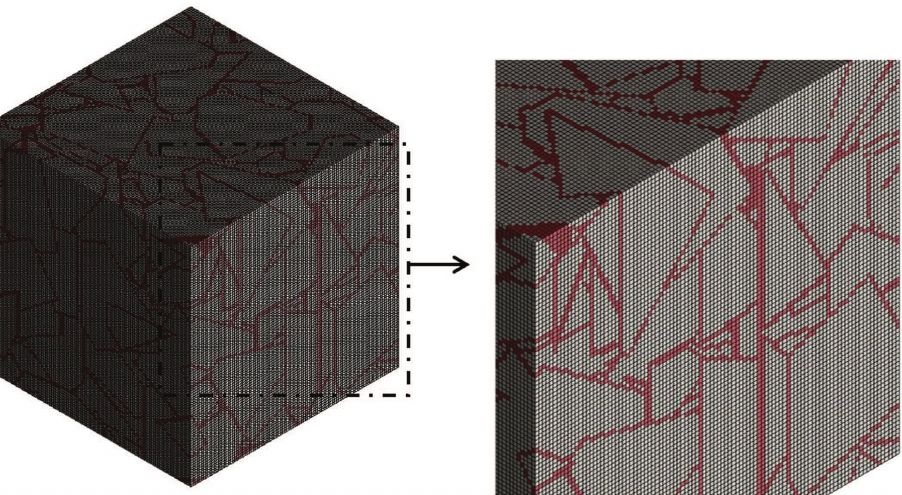
Figure 11: Finite element discretization of three-dimensional microgeometry including continuous boundaries between tungsten carbide